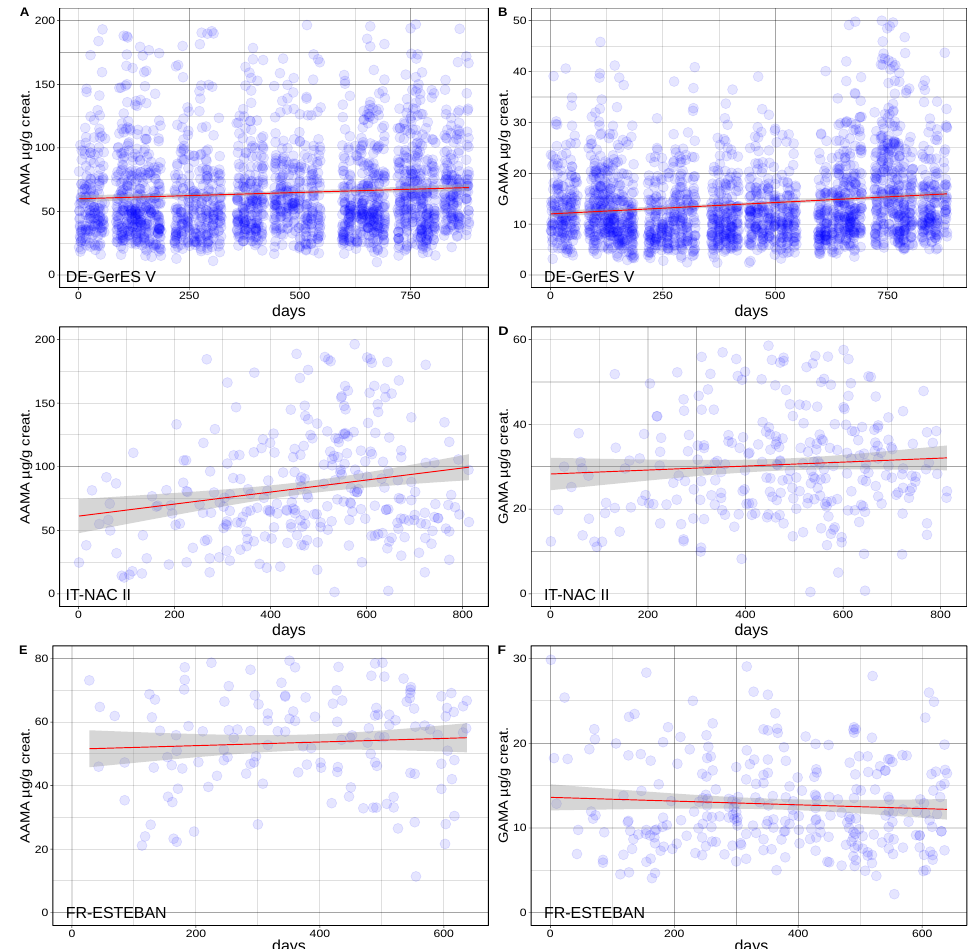
Figure A2. Time-trend of AAMA and GAMA urine concentrations in µg/g creatinine (per sampling day, 0 = first day of sampling) in individual data (non-smoker, children and teenagers) HBM4EU aligned studies from Germany (UBA, GerES V, A , B ), Italy (EUPID, NAC II, C , D ) and France (ESTE- BAN, E , F ). Linear fit in red, gray = 95% confidence interval. Table A2. Estimated slope (s) and statistical significance of a multiple linear regression for AAMA and GAMA in µg/g creatinine (after normalization by logarithmic transformation using natural logarithm, ln) and in function of the sampling day in adults. ***: p < 0.001, **: p < 0.01, ns: not significant.